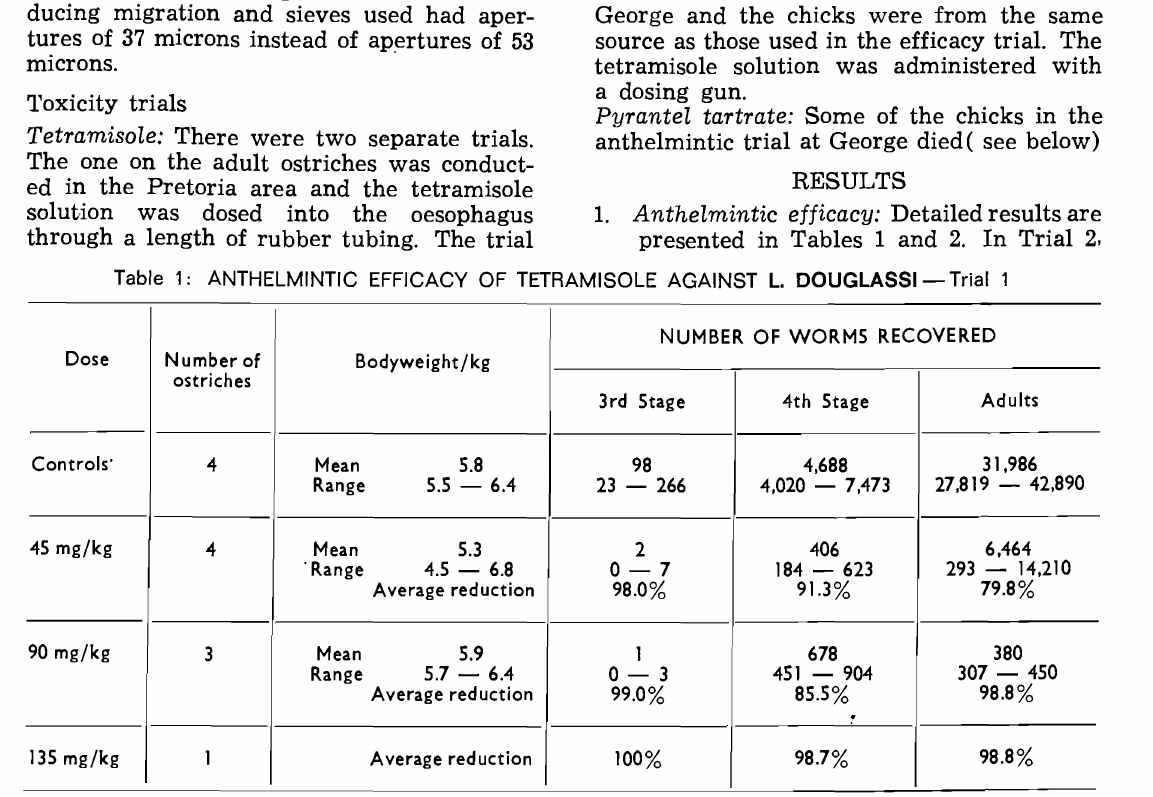
Table 2: ANTHELMINTIC EFFICACY OF TETRAMISOLE HYDROCHLORIDE AND PYRANTEL TARTRATE AGAINST L. DOUGLASSI - Trial